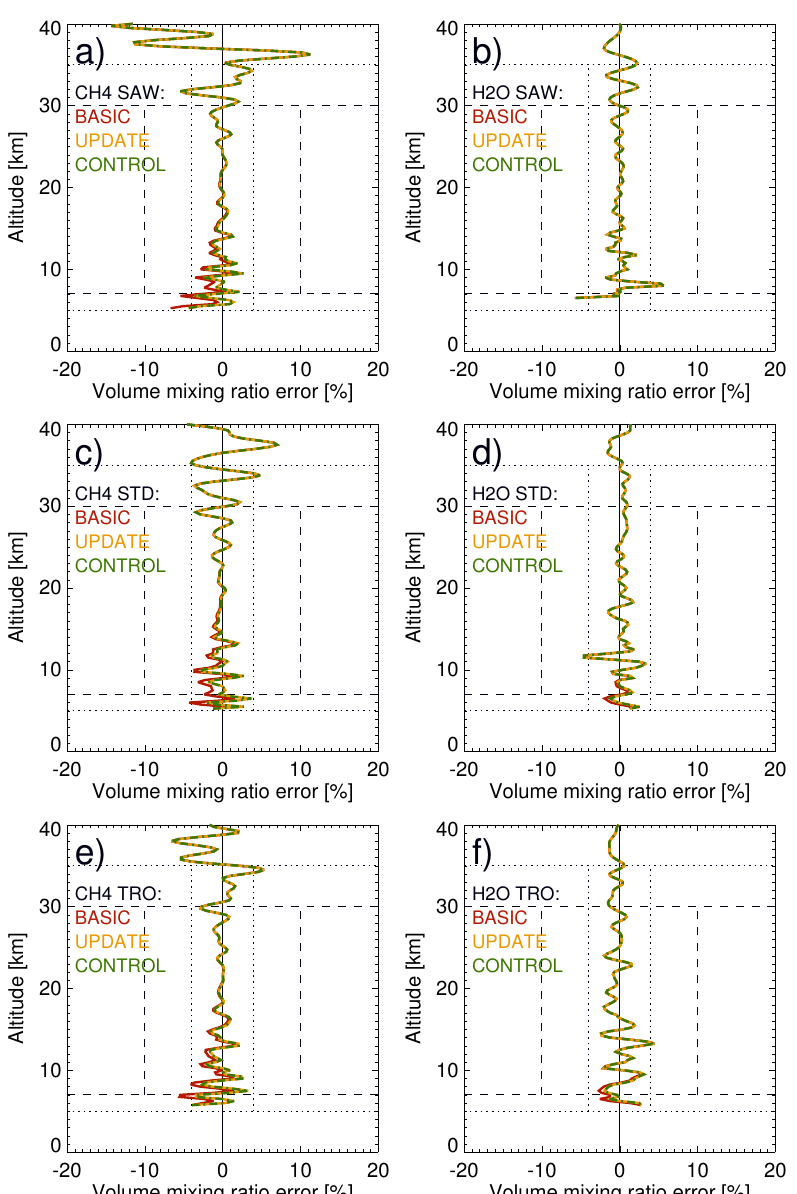
Fig. 8. Retrieval performance results of the LMIO end-to-end simulations for CH 4 (left column) and H 2 O (right column). VMR retrieval errors are shown for sub-arctic winter (top), standard (middle), and tropical (bottom) atmosphere conditions, for GHG retrieval results after the basic run (red line), update run (yellow line) and control run (green dashed-dotted line) of the basic-update-control run (BUC) loop.